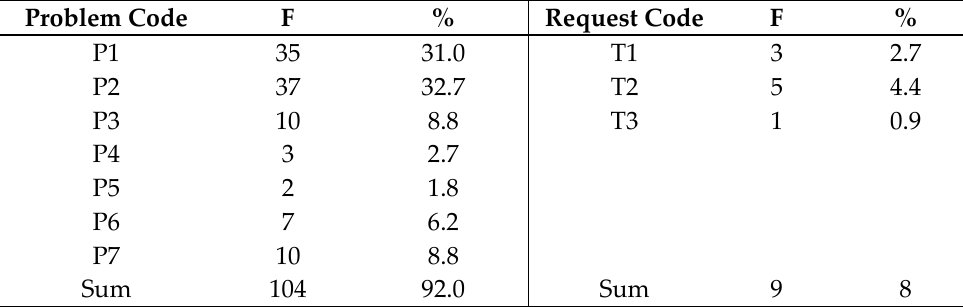
Table 2. Frequency and percentage distributions of support request